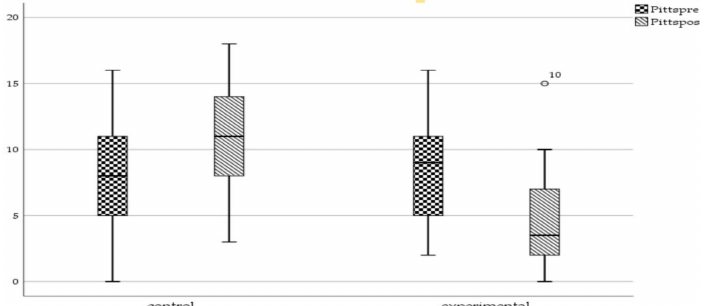
Figure 3. Box whisker graphic of the Pittsburgh index in control and experimental groups (pre- and post-test